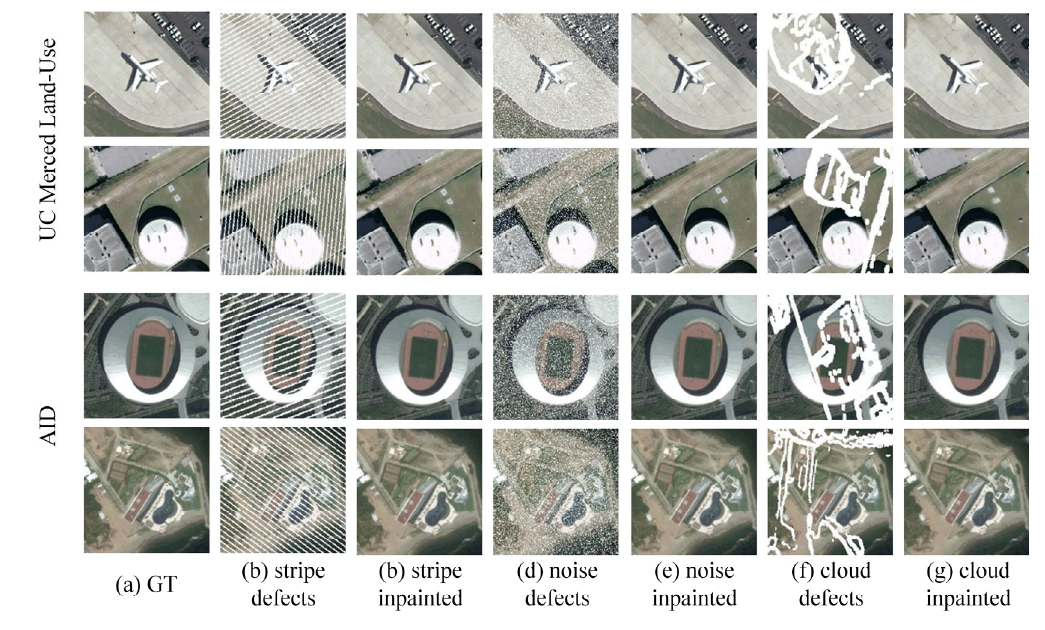
Figure 16. Inpainting results of UC Merced land-use dataset and AID dataset. Table 7. OA (%) and ROR (%) of F2BRBM and F2BRBM + LPIN on UC Merced Land-use Dataset and AID Dataset.